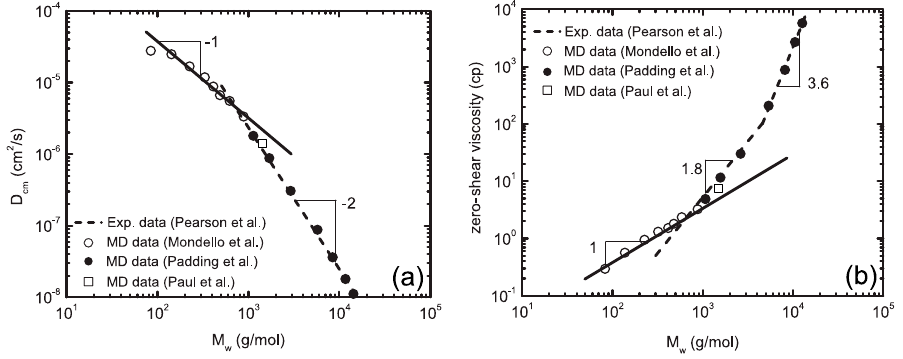
Figure 6. ( a ) Center-of-mass self-diffusion coefficient, D cm ; and ( b ) zero-shear viscosity versus molecular weight, M w , for PE melts at 450 K. Reproduced from Padding and Briels [386] with the permission of AIP Publishing. For further information regarding the various sets of data shown in figure refer to the cited work and the references within it.